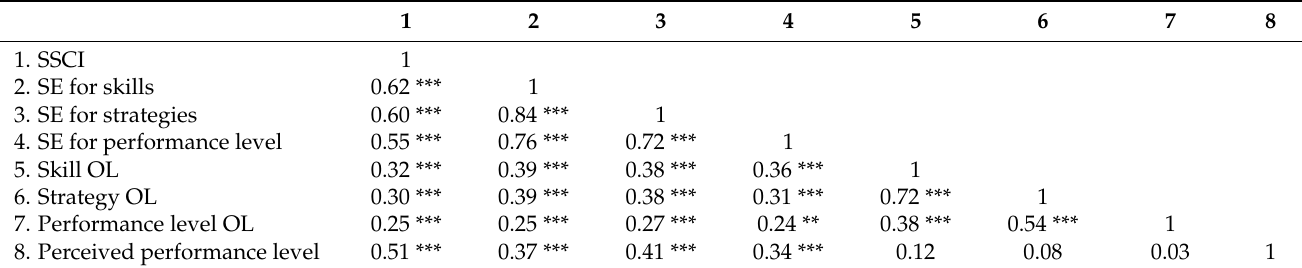
Table 1. Correlation Coefficients and Perceived Performance